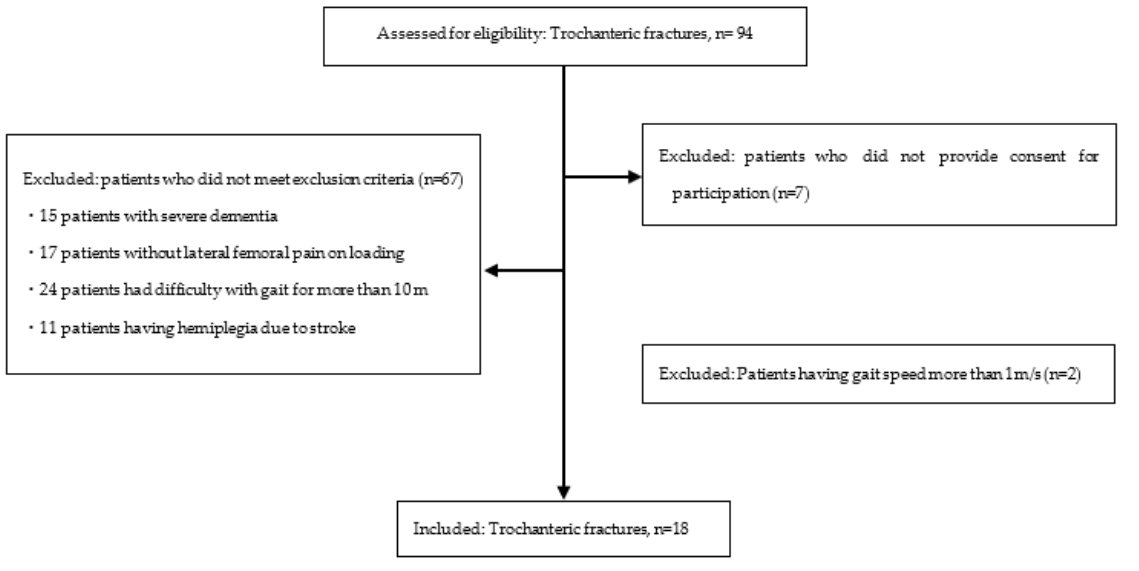
Figure 2. Patient flow scheme accounting for inclusion criteria. Table 1. Measurement results.